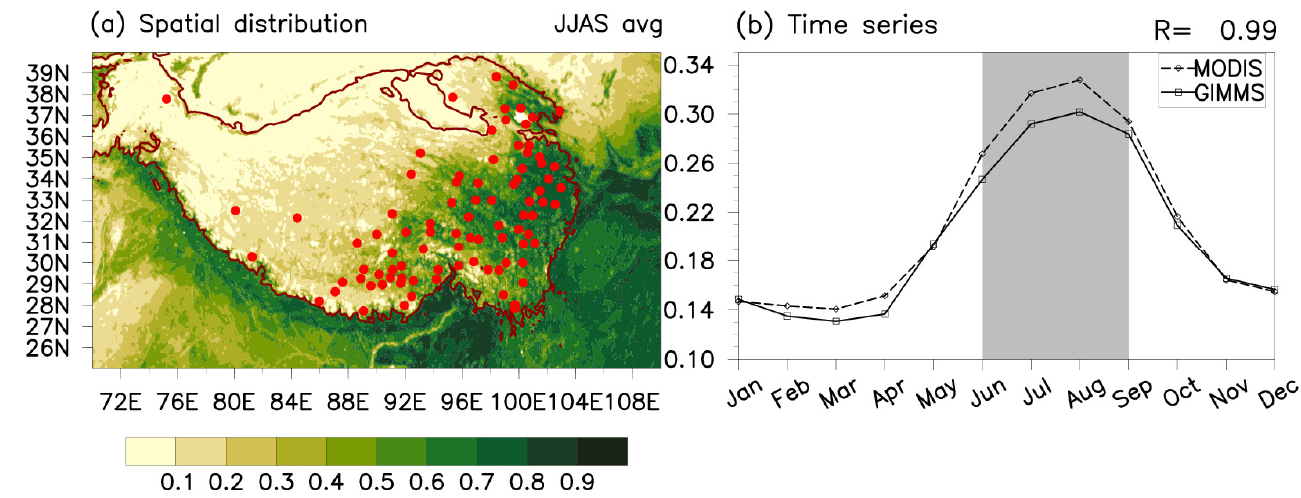
Figure 1. ( a ) Map showing the location of the study area and 88 meteorological stations (red dots) within the boundary of the TP (3000 m above sea level; brown lines). Shadings denote the TP NDVI during the main growing season (JJAS) for the period 2002–2014. ( b ) Annual cycles of the TP NDVI for the period 2002–2014. The gray shading indicates the TP vegetation during JJAS, and the solid and dashed lines represent the monthly evolution of the GIMMS and MODIS NDVIs, respectively.